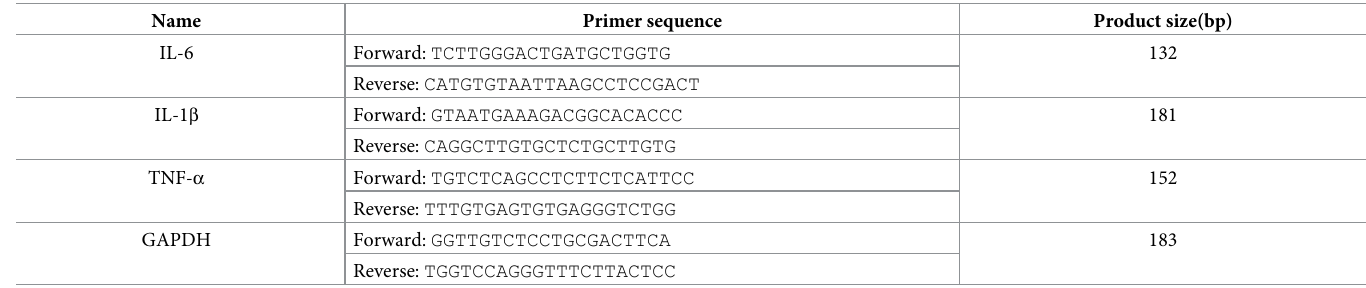
Table 1. Primers for